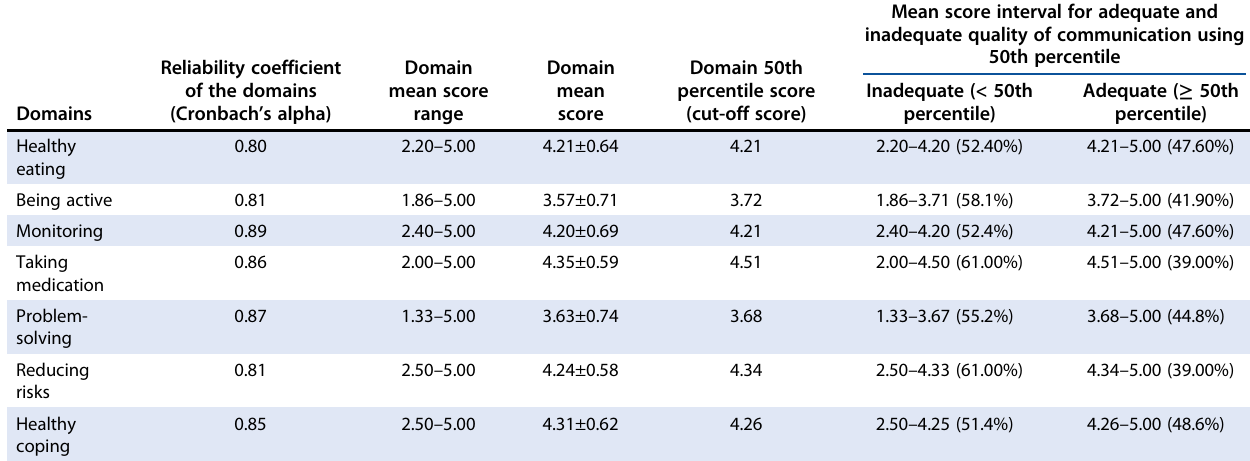
Table 2: Summary descriptions of the scale used for data collection and the self-developed cut-off points for the model